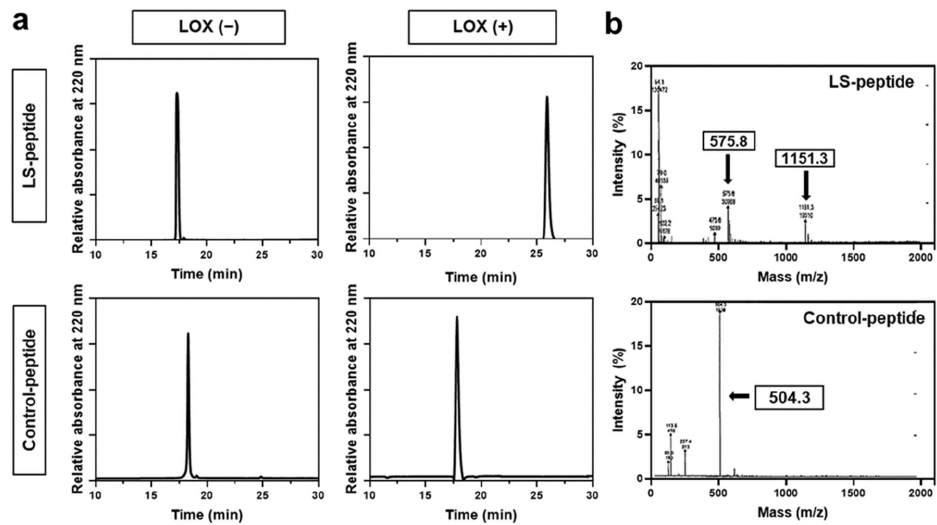
Figure 2. ( a ) HPLC profiles of the LS-peptides and control peptides before and after the addition of LOX. ( b ) Mass spectrometry of the reaction mixture LS-peptides + LOX or control peptides + LOX.